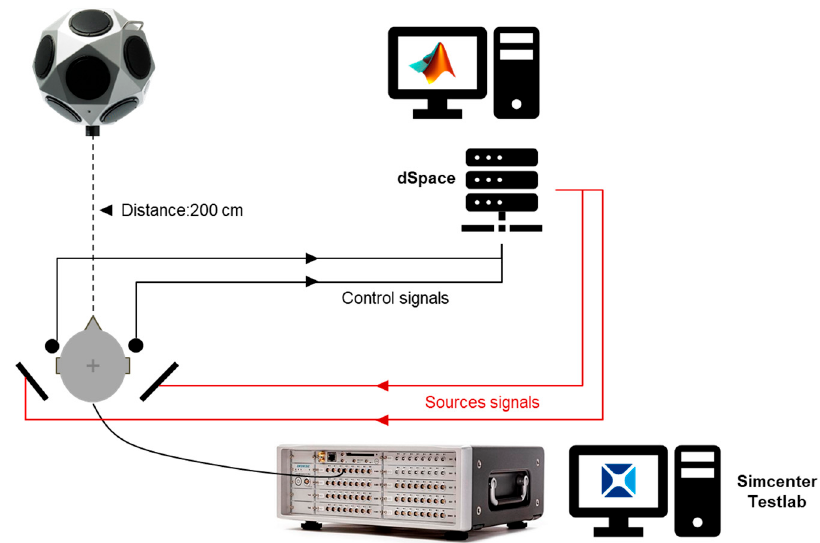
Figure 7. Block diagram of the control and acquisition chains.